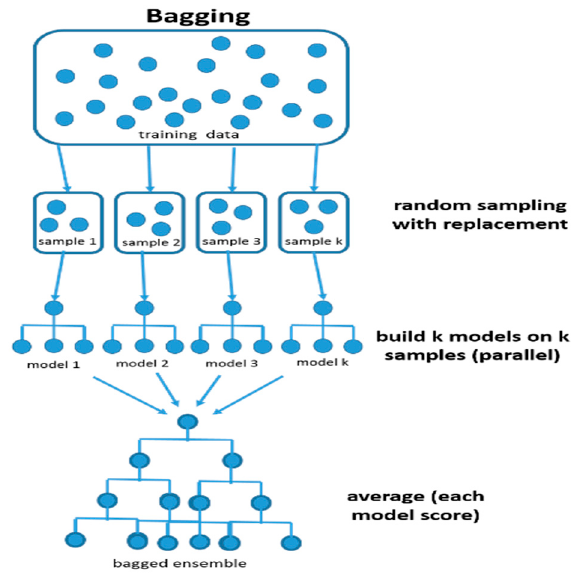
// www.kdnuggets.com /